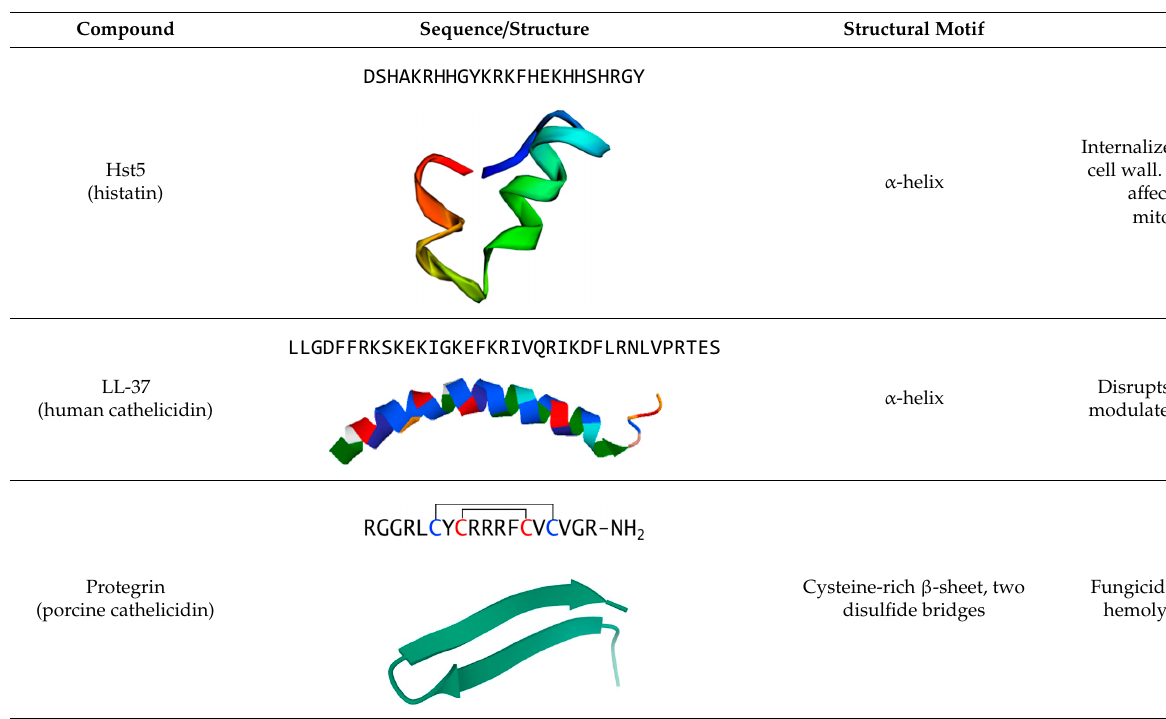
Table 3. Representative host defense peptides (HDPs) and mimics.